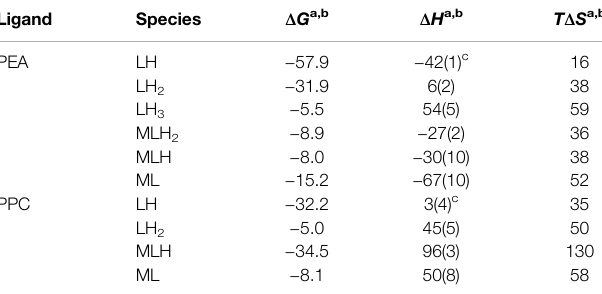
TABLE 4 | Thermodynamic parameters of protonation of PEA and PPC and of formation of Mg 2+ -PEA and Mg 2+ -PPC species at t = 25 ° C and I = 0.15 mol L − 1 in